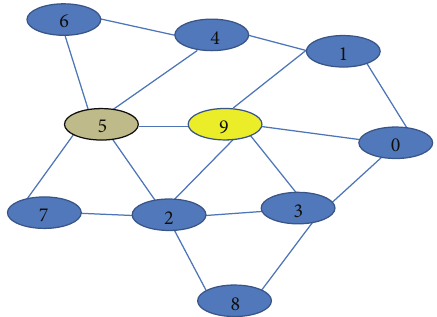
Figure 3: ECHSA select cluster